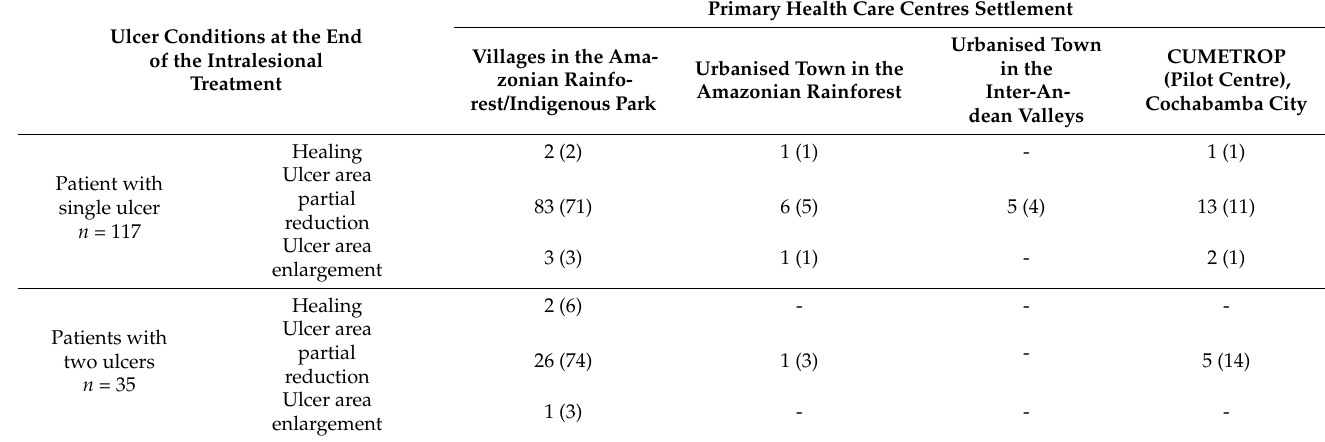
Table 2. Patients with single or two ulcers and their conditions at the end of the intralesional treatment period, with meglumine antimoniate by the settlement of primary health care centres. Data presented as frequencies (%).